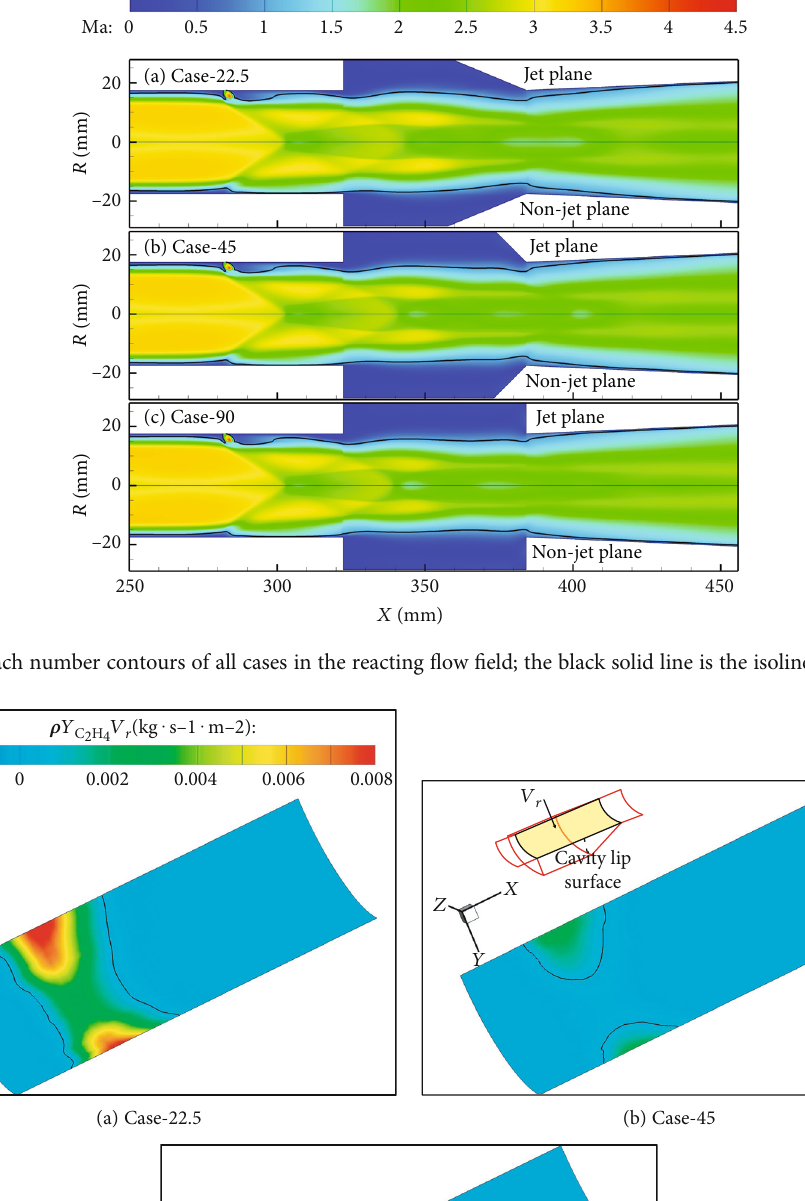
Figure 13: The cavity fuel mass exchange rate for all cases; the cavity lip surface is displayed as the yellow surface in the schematic diagram in